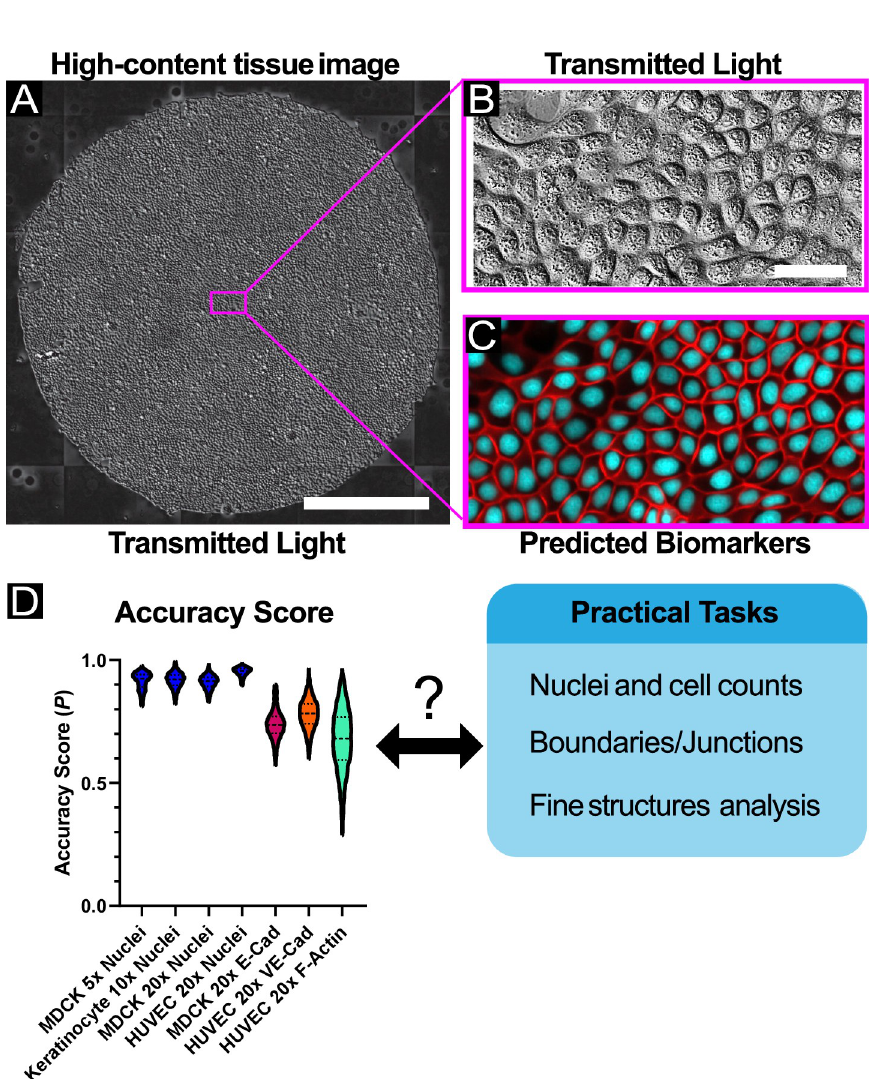
A representative image which is given as input to the U-Net processing framework. The scale bar represents 50 μ m. (C) The predicted fluorescent features (cell-cell junctions and nuclei) produced by the U-Net, corresponding to the same spatial region as in B. (D) Violin plot of accuracy score results from all experimental datasets. N > 4400 raw images and > 20,000 sub-images for all datasets; see S1 Table for summary statistics. Here, the accuracy score (P) represents the Pearson’s correlation coefficient between ground truth images containing positive examples of features and their matched reconstructed images. See Methods